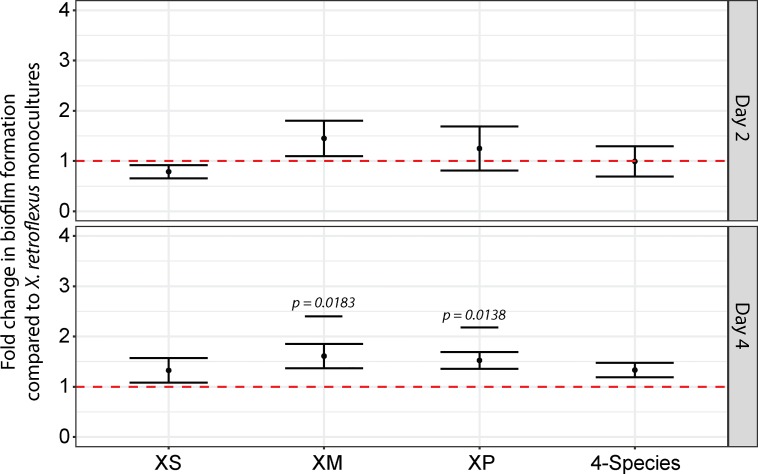
Quantification of cells associated to keratin particles.Q-PCR analysis was based on universal eubacterial 16s rDNA gene primers. Keratin particles were isolated from mono- and co-cultures after 2 and 4 days of incubation. Counts of 16S gene copy numbers were believed to correspond to cells associated to the particles in a biofilm state. Co-culture counts were compared to counts of X. retroflexus mono-cultures. Dotted red line corresponds to the X. retroflexus mono-culture. Co-cultures are represented by letters of their constituent species; e.g. X.retroflexus–S.rhizophila (XS), X.retroflexus–M.oxydans (XM) and X.retroflexus–P.amylolyticus (XP). At day 2, the level of adhered cells was not significantly different between co-cultures and the X. retroflexus mono-culture. At day 4, the co-cultures trended an increased fold change of adhered cells, as compared to the X. retroflexus mono-culture. Co-cultures of X.retroflexus–M.oxydans and X.retroflexus–P.amylolyticus had a significantly increased fold change (Lin. 3).